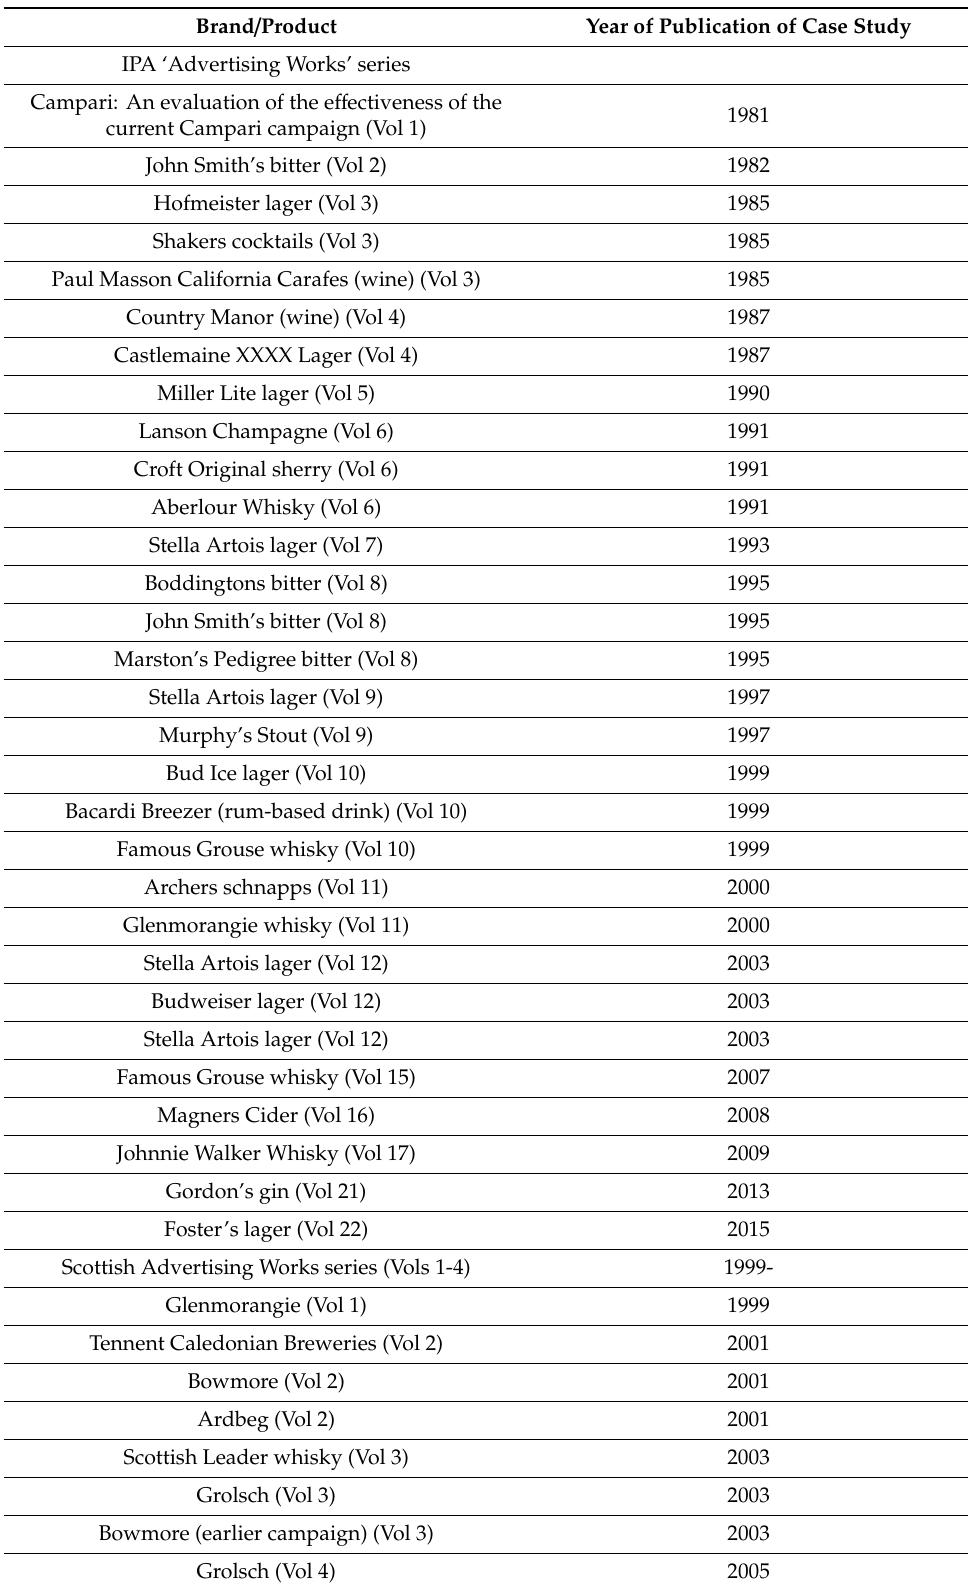
Table 2. Brands evaluated in each case study, category of beverage, and year of publication. IPA: Institute of Practitioners in Advertising. Brand / Product Year of Publication of Case Study IPA ‘Advertising Works’